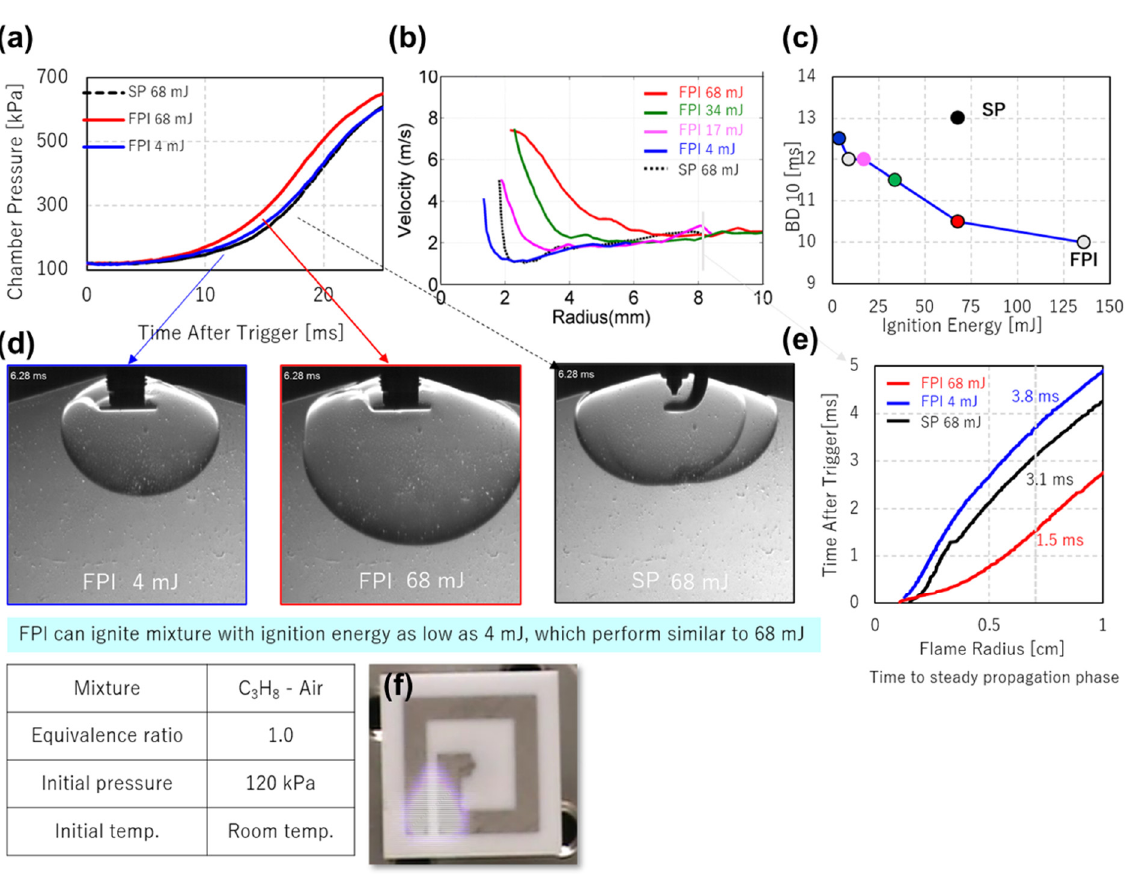
Figure 15. Effects of ( a ) time after trigger on chamber pressure, ( b ) flame kernel radius on plume velocity, ( c ) BD10 (pressure increase of 10%) in flat panel igniter (FPI). ( d ) Actual images of flame kernel after 6.28 ms for the low energy (4 mJ) FPI, and high energy (68 mJ) FPI and spark plug (SP). ( e ) Correlation of flame radius vs. time after trigger shows a shorter time (1.5 ms) to enlarge the flame kernel in FPI. ( f ) Top view image of flame kernel [31].